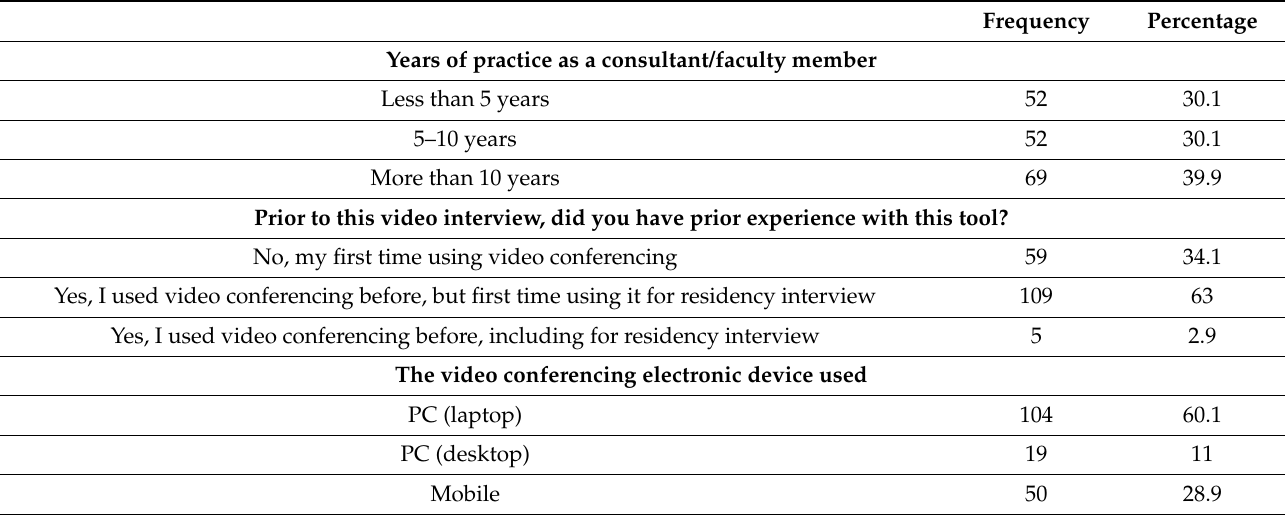
Table 1. Baseline characteristics of the faculty members.